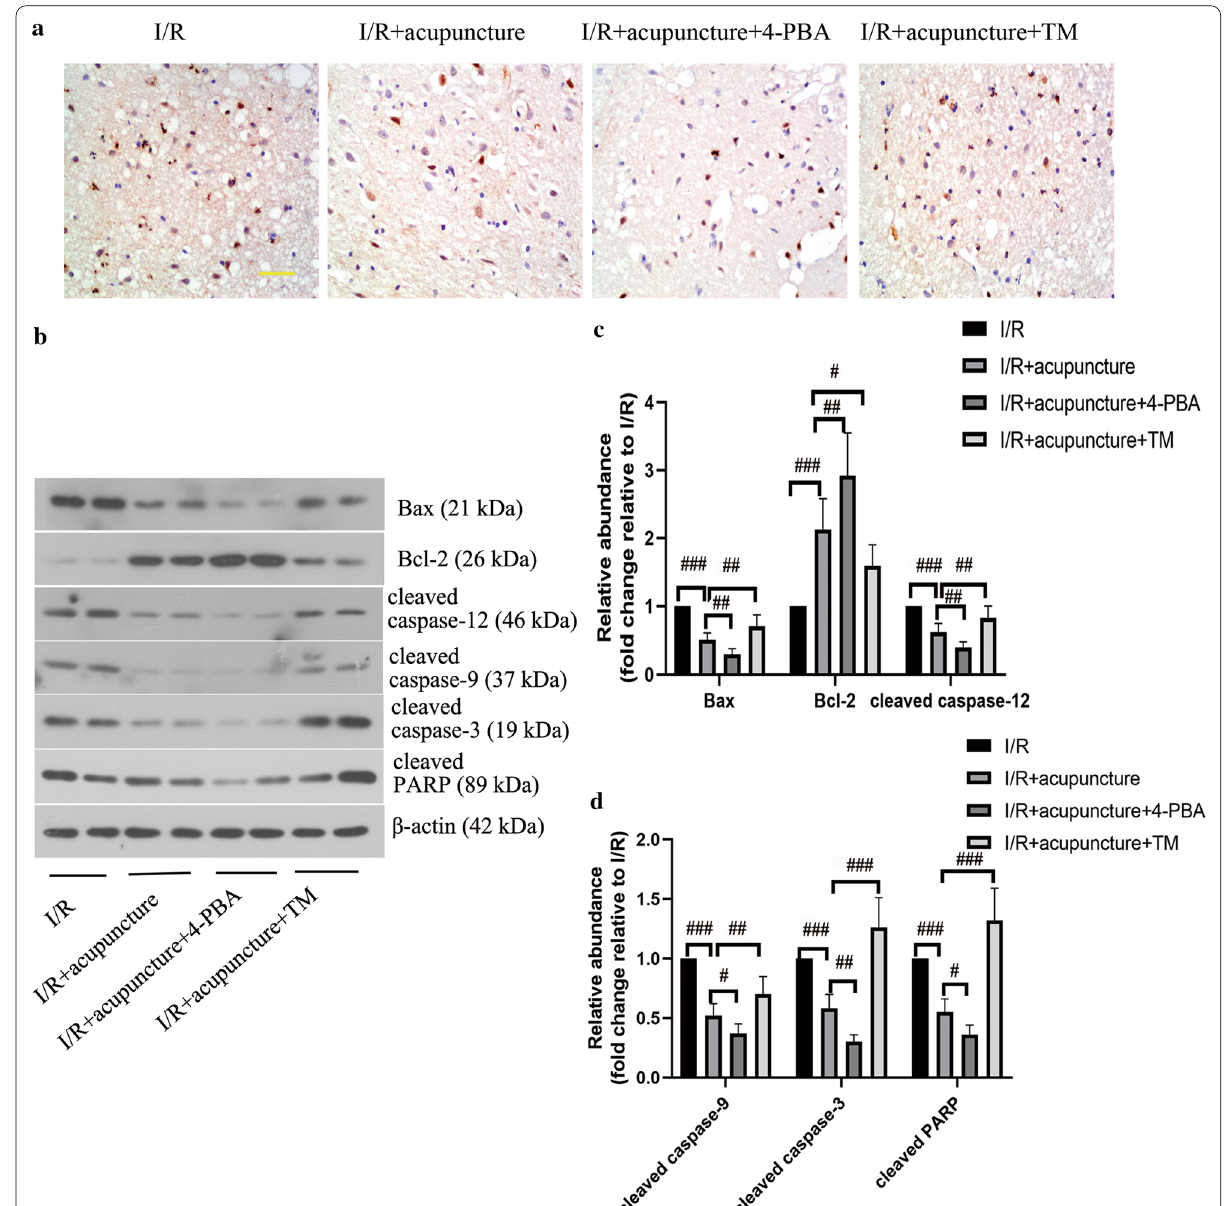
Fig. 9 Endoplasmic reticulum (ER) stress was involved in the neuroprotective effect of acupuncture against apoptosis in cerebral ischemia– reperfusion (I/R) injury. Experiments were performed at 72 h after the reperfusion in the ipsilateral brain tissues. a The apoptosis in brain tissues was evaluated by TUNEL assay. Scale bars, 50 μm. b The protein levels of Bcl-2 Associated X Protein (Bax), B-cell lymphoma-2 (Bcl-2), cleaved caspase-12, cleaved caspase-9, cleaved caspase-3, and cleaved poly ADP-ribose polymerase (PARP) in brain tissues were detected by Western blotting assay. β-actin was used as an internal control. c , d The relative abundance of the protein bands was calculated and shown. Results represent at least three independent experiments. Each experimental result was presented as mean standard deviation (n 6). # P < 0.05, ## P < 0.01, ### P < 0.001 versus the ± = indicated